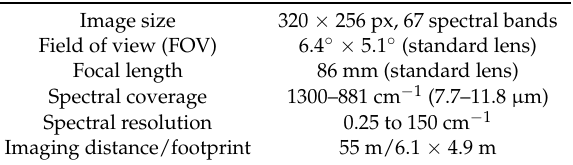
Table 3. Sensor specifications of the Telops Hyper-Cam LW thermal hyperspectral